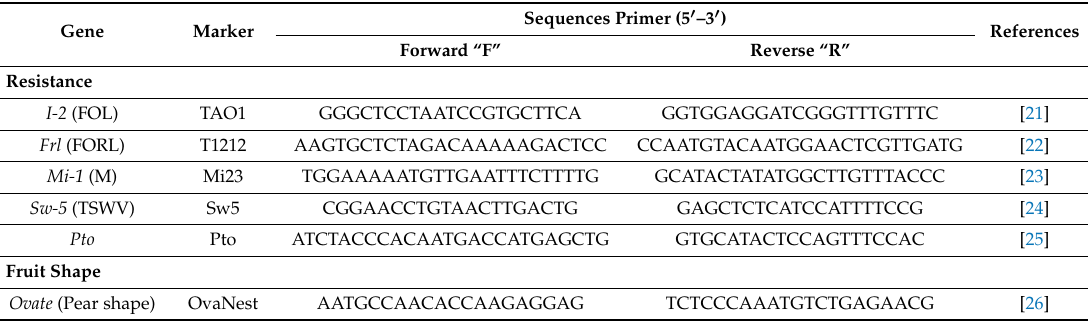
Table 2. List of characters analyzed and primes